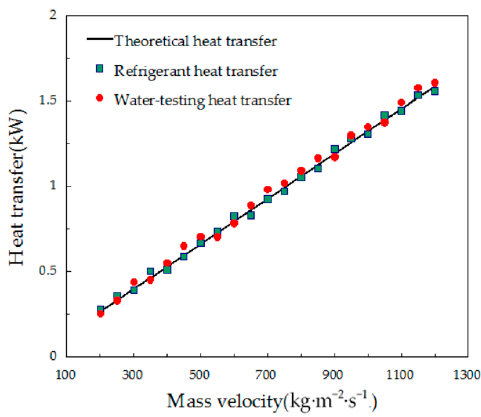
Figure 4. Comparisons of heat transfer rate between refrigerant/water-testing experimental value and theoretical value for a single-phase flow.